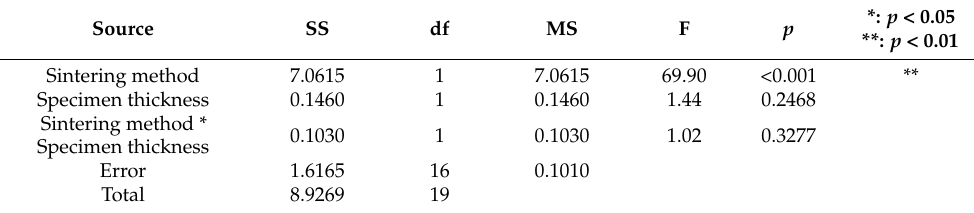
Table 6. Results of two-way ANOVA statistical analysis for fracture toughness